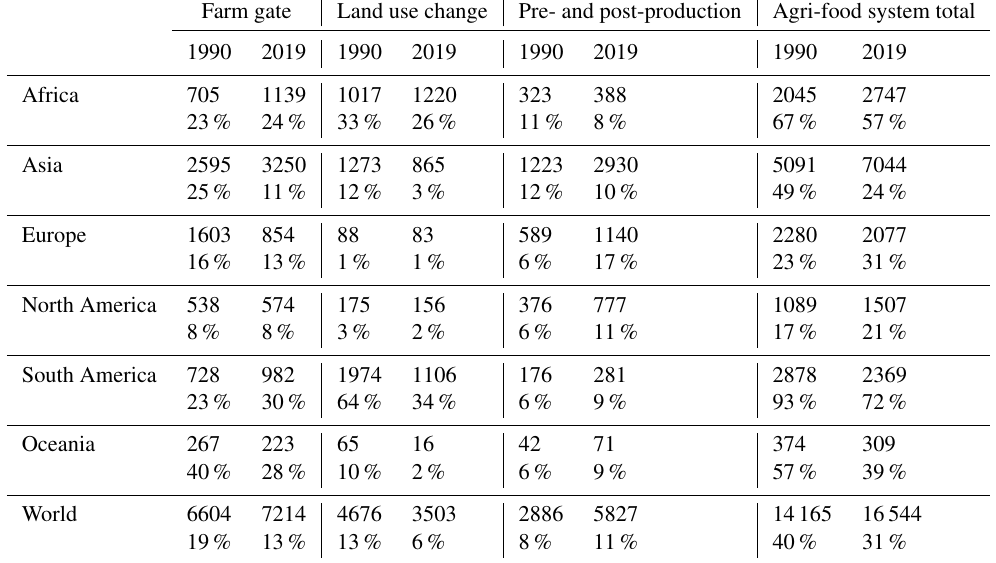
Table 5. Regional GHG emissions (MtCO 2 eq.) by agri-food system component and total food system emissions, 2019. The last two columns show the dominant sub-component of pre- and post-production processes. Uncertainties (not shown) are estimated at 30% for farm gate and pre- and post-production components and at 50% for land use change